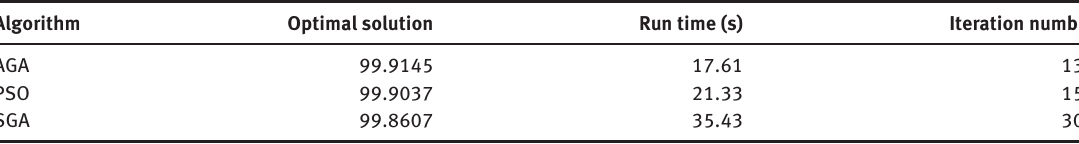
Table 2. Comparison of Different Algorithms’ Optimized Results.